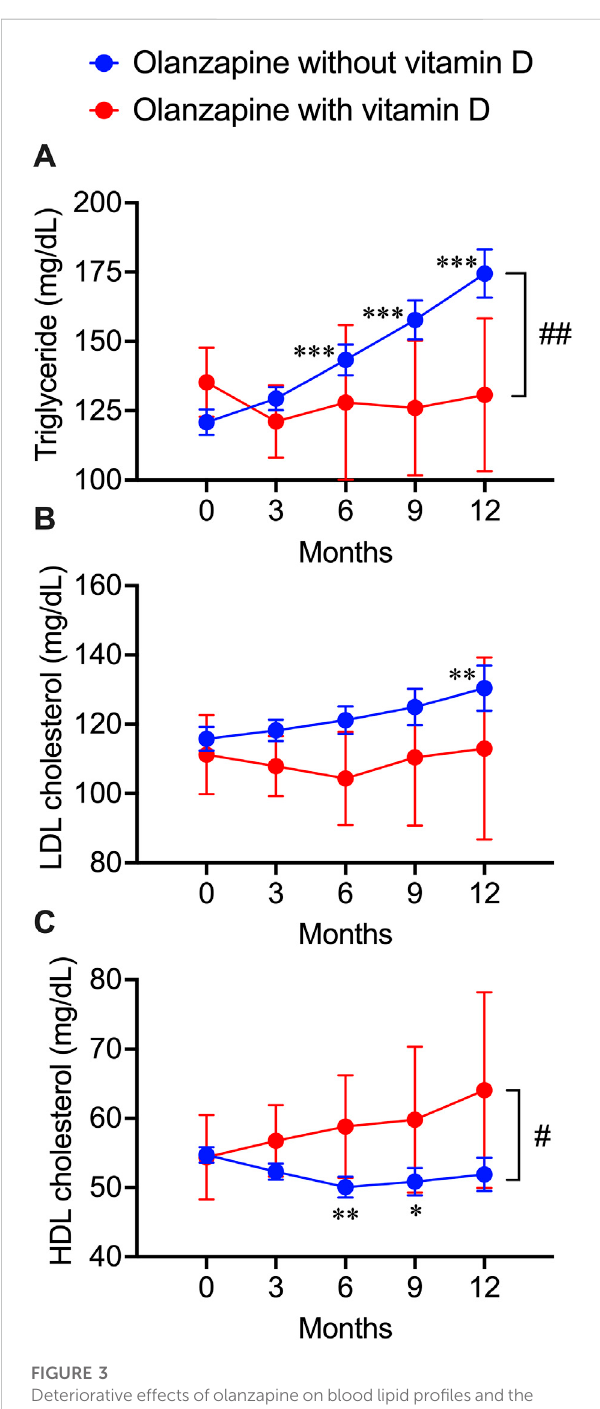
FIGURE 3 Deteriorativeeffects ofolanzapine on blood lipid pro fi les and the rescuing effects of vitamin D co-treatment from electronic health records of the clinical data warehouse of Nihon University School of Medicine. Blood test results were extracted every 3 months after the fi rst prescription of olanzapine. (A) the triglycerides ( n = 406 in olanzapine without vitamin D group; n = 23 in olanzapine with vitamin D group), (B) the LDL cholesterol levels ( n = 154 in olanzapine without vitamin D group; n = 11 in olanzapine with vitamin D group), and (C) the HDL cholesterol levels ( n = 258 in olanzapine without vitamin D group; n = 16 in olanzapine with vitamin D group) were expressed in units ofmg/dL. Data are shown as means ± SEM. * p < 0.05, ** p < 0.01, *** p < 0.001; a paired t -test of data on any months after the olanzapine prescription against the data on month 0 (baseline). # p < 0.05, ## p < 0.01;an unpaired two-tailed t- testwithWelch ’ scorrection between the groups with and without vitamin D